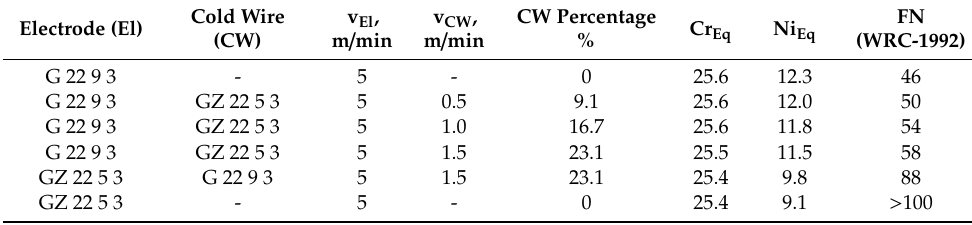
Table 2. Calculated ferrite numbers (FN) for di ff erent mixing ratios of the filler metals. Electrode